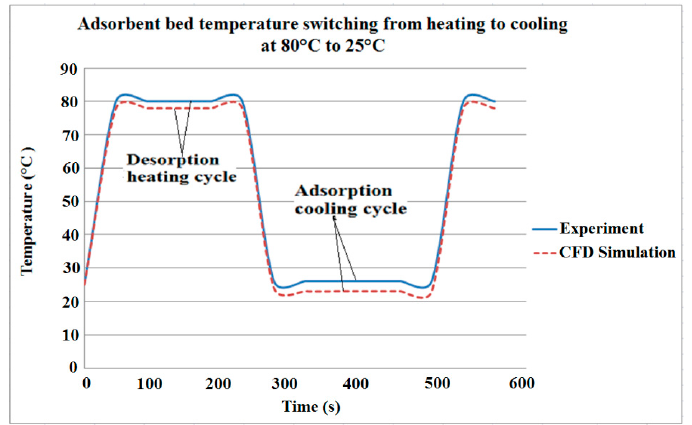
Figure 28. Comparison of the outlet temperature of the CFD simulation and the experiment data by J. White ©2012 [10].